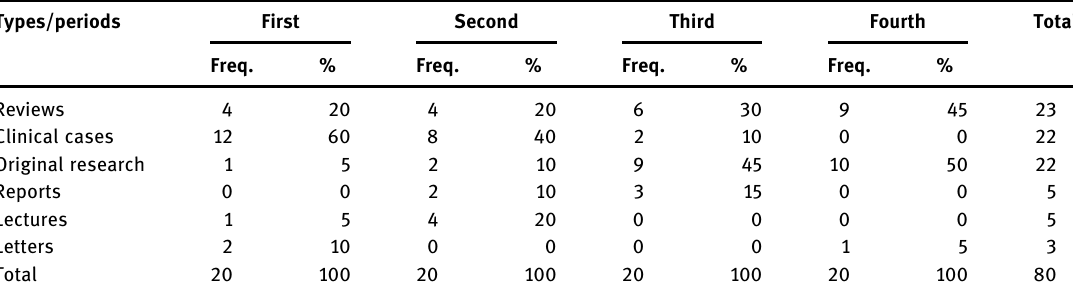
Table 1: Types of articles over the four